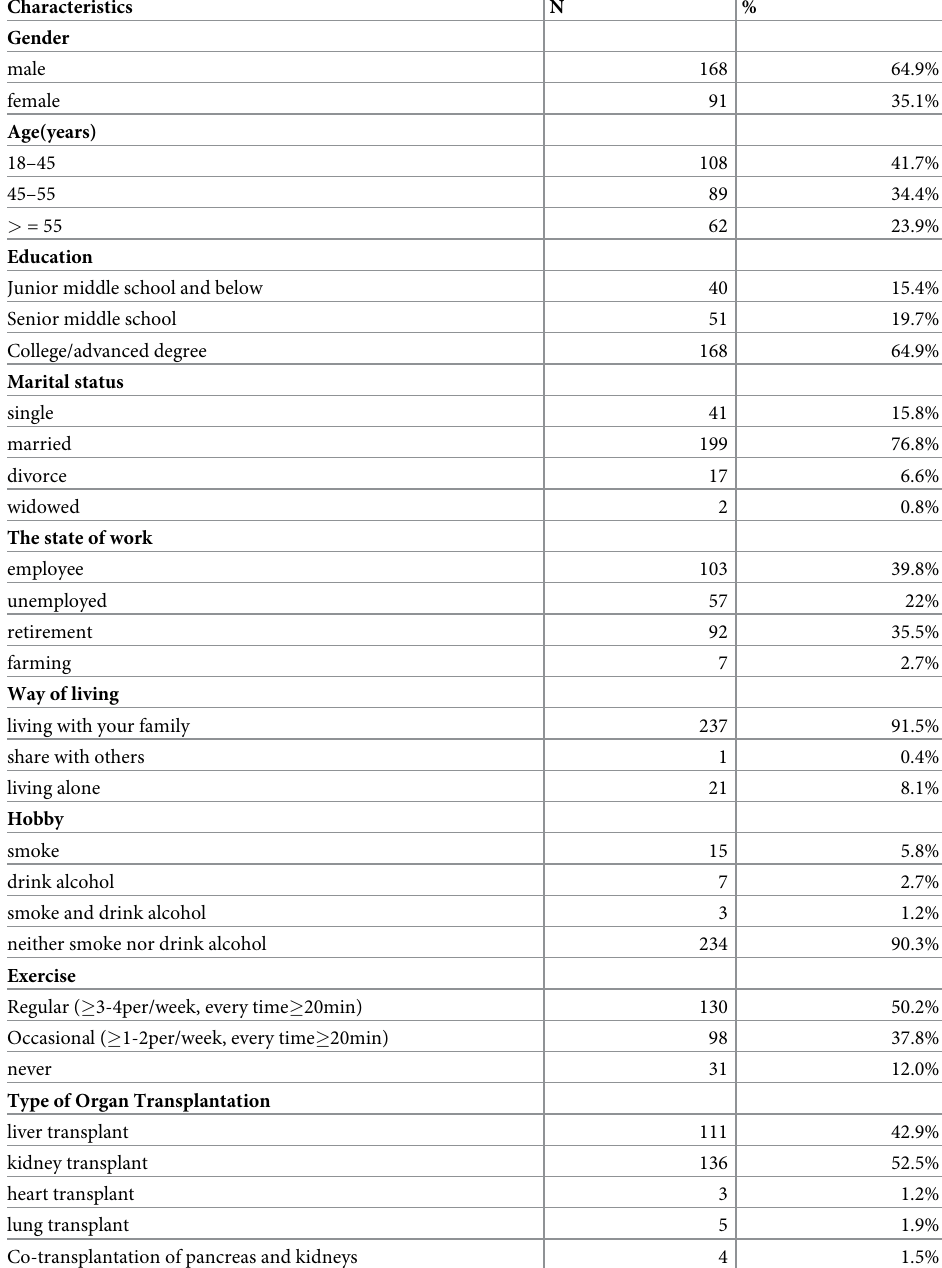
Table 2. Demographic and clinical characteristics of participants.